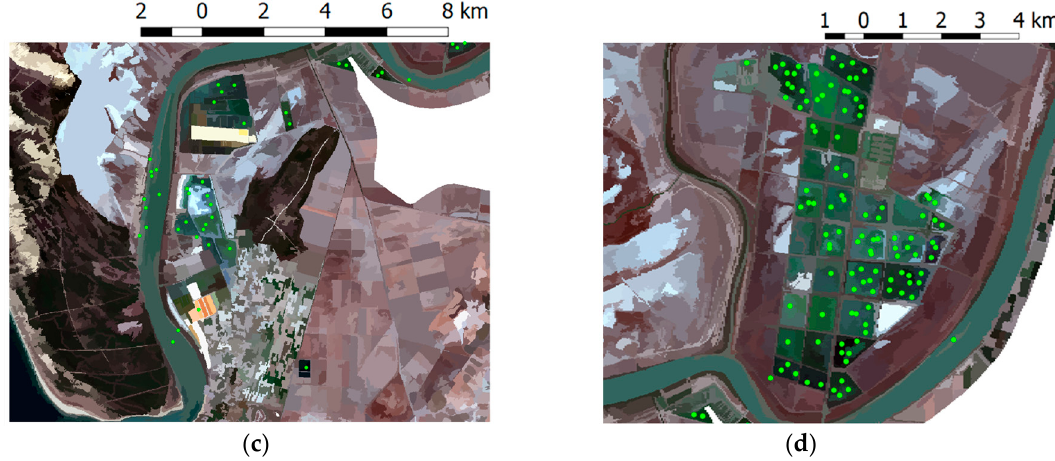
5. Figure 5. ( a ) Initial inundation map generated after applying T init to the SWIR band (the centroids of the segments having a large percentage of inundated pixels are visualized as green dots) with three subsets denoted on the map; ( b ) additional inundated pixels found after applying T final to the SWIR band, compared to the initial inundation map, for Subsets 2 and 3; ( c ) the mean-shift segmentation map of Subset 1 with the included centroids; and ( d ) the mean-shift segmentation map of Subset 2 with the included